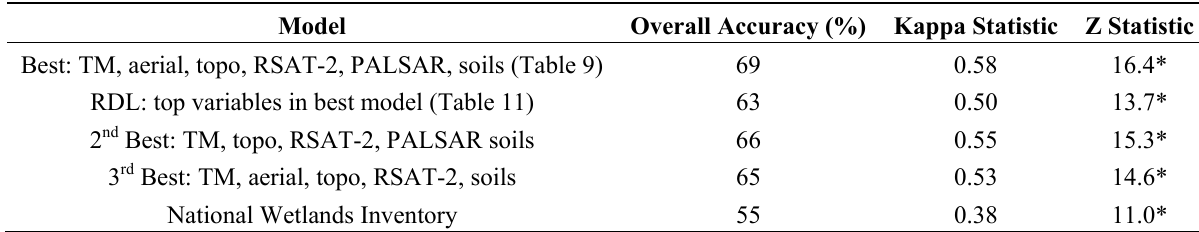
Table 10. Error matrix summary of the three best full season random forest models for the Level 2 classification.